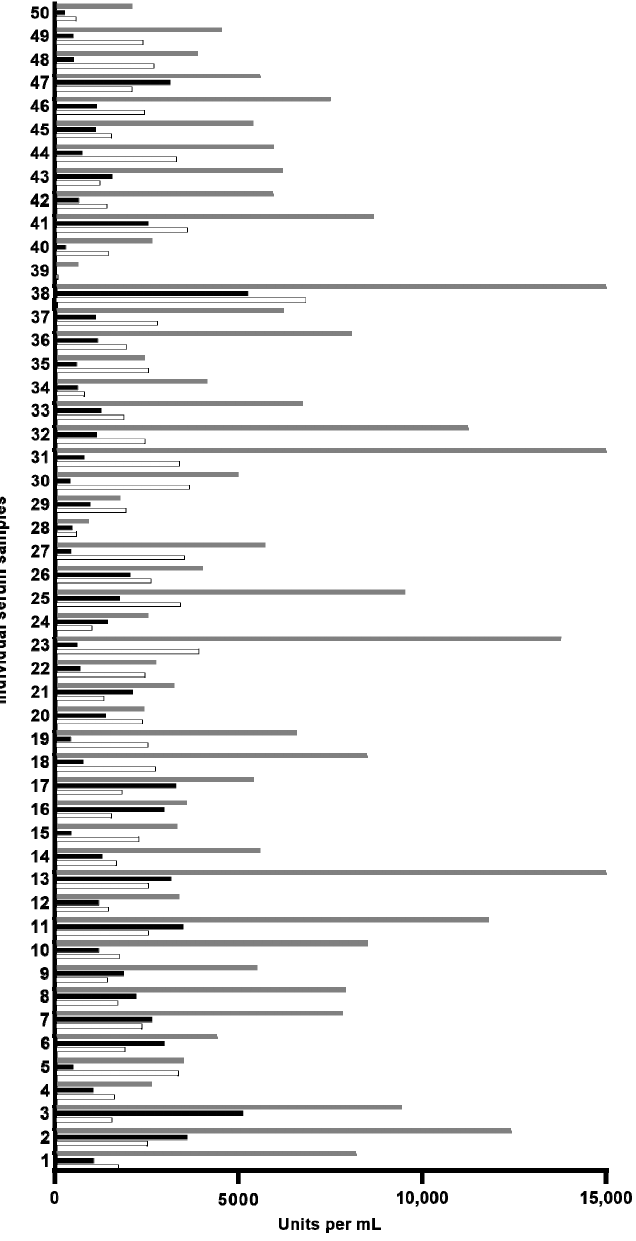
Figure 1. Quantification of anti-SARS-CoV-2 antibodies by all three tests. X-axis gives units per mL, by definition BAU and IU are numerically identical.